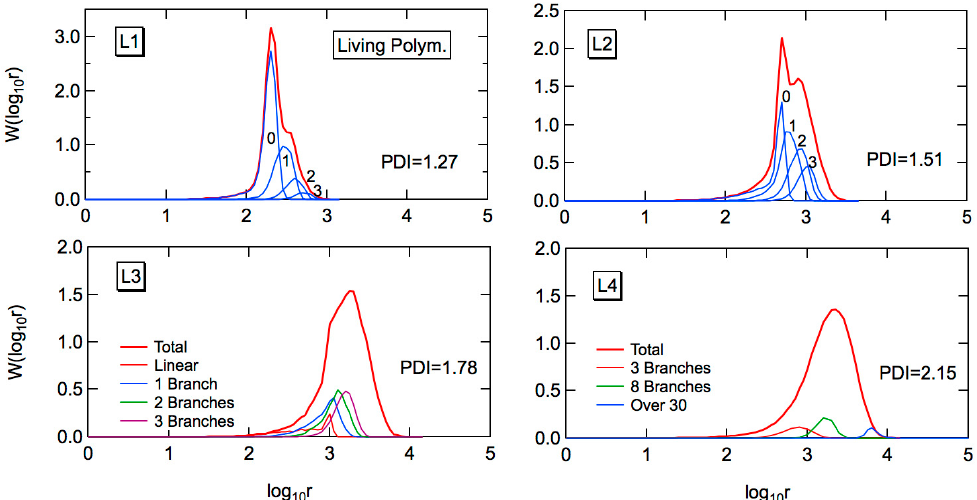
Figure 5. Weight fraction distribution determined by the MC simulation for the living emulsion polymerization, for the conditions, L1–L4. The PDI values in the figure are determined also from the MC simulation results.